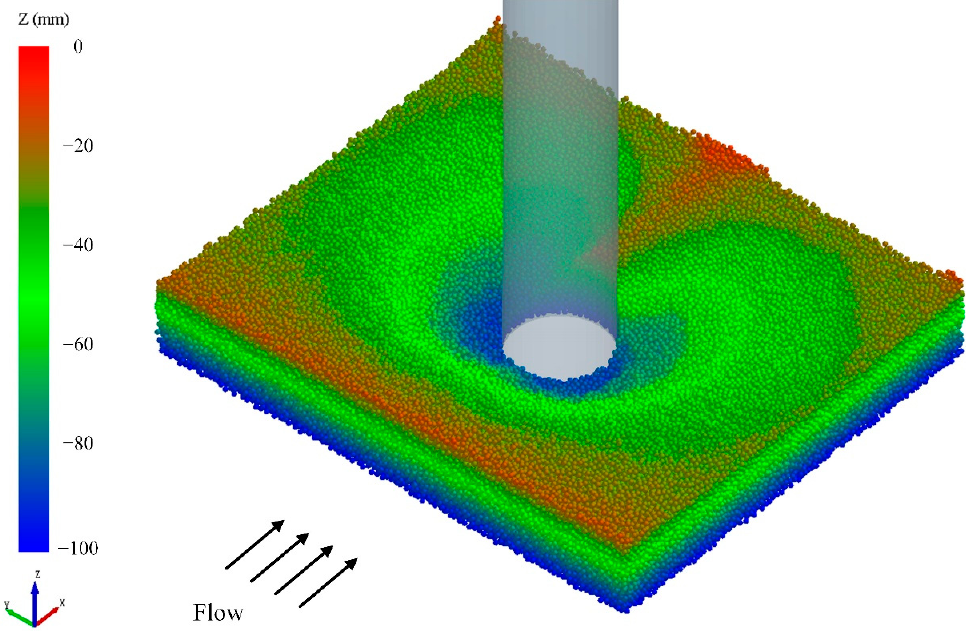
Figure 6. 3D view of scour pit at the equilibrium stage. Flow direction is in the x -axis, and the color represents different scour depths.